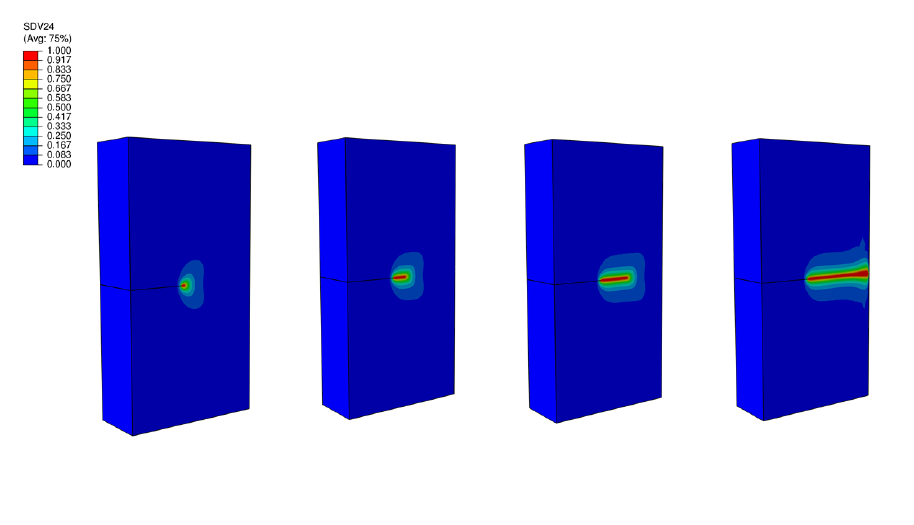
Figure 4. Crack path with increasing time steps.